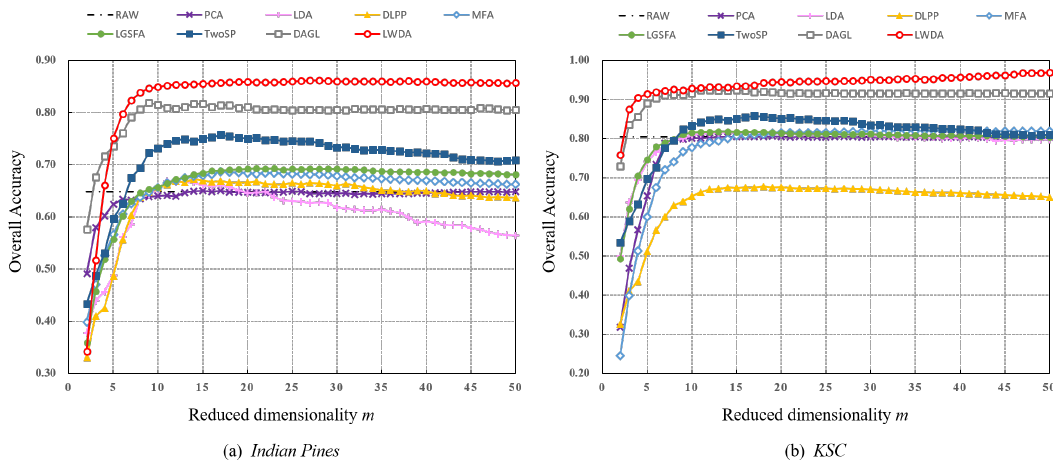
Figure 6. Overall classification accuracy (OA) versus the reduced dimensionality of different methods with NN classifier on the ( a ) Indian Pines and ( b ) KSC datasets using τ =